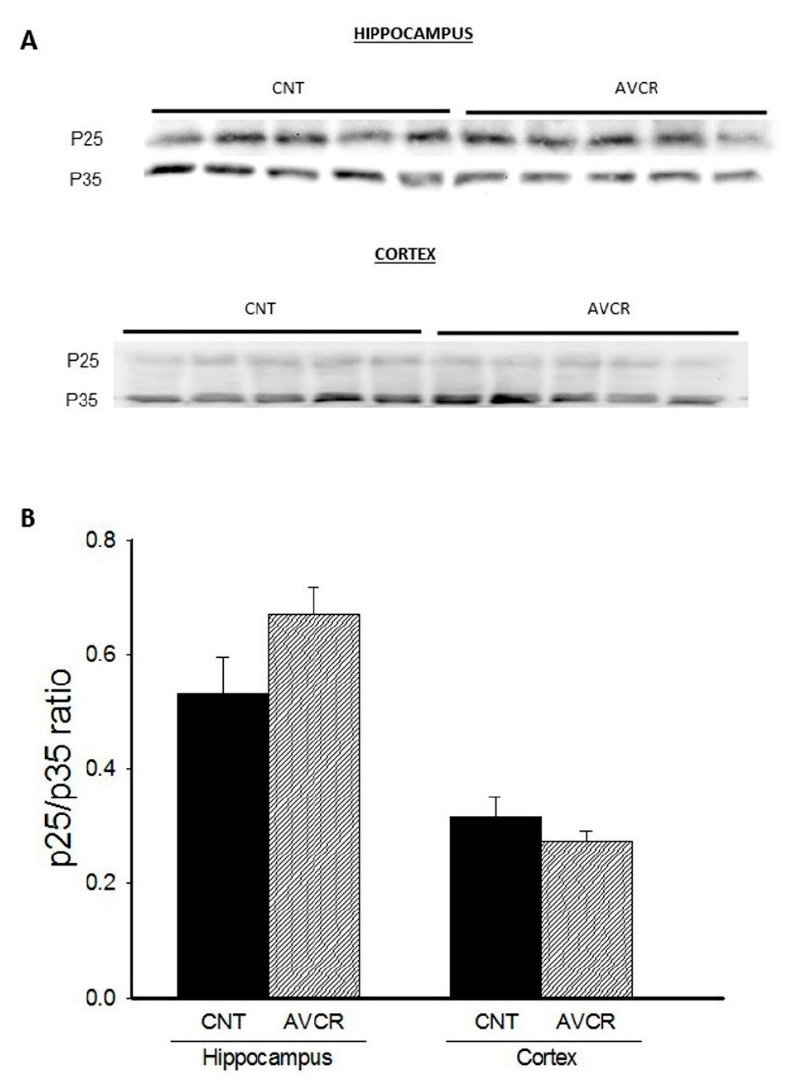
Figure 4. Effect of AVCRI104P3 on p25/p35 ratio in the hippocampus and cortex of 12-month-old 129/Sv × C57BL/6 male mice. ( A ) Representative Western blot images of p25/p35 ratio. β -actin were used as internal control. ( B ) Photodensitometric quantification of WB experiments was used to evaluate changes in the p25/p35 ratio. The results are the mean ± SEM of 3–4 experiments (5 mice/treatment group). The statistical analysis used was one-way ANOVA followed by Dunnett’s test.